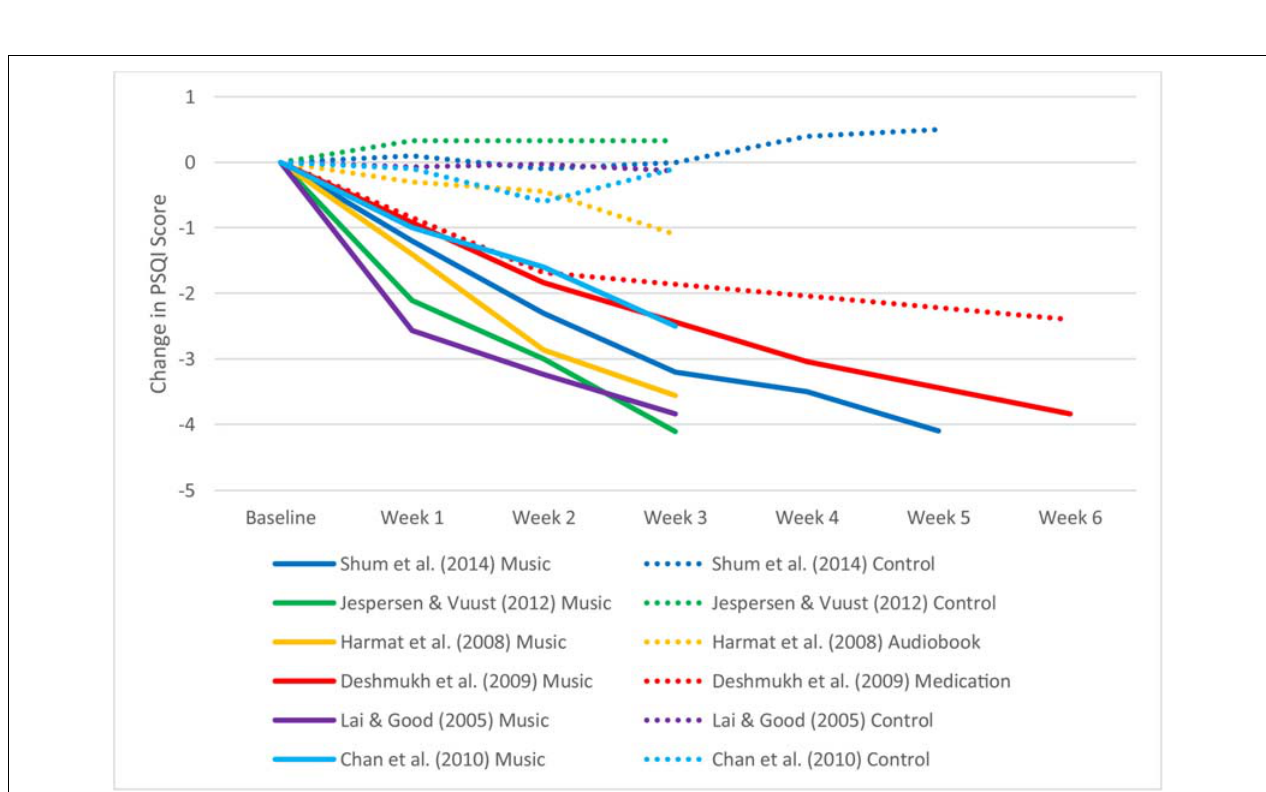
FIGURE 3 | The difference from baseline Pittsburgh sleep quality index (PSQI) scores for music interventions by time.